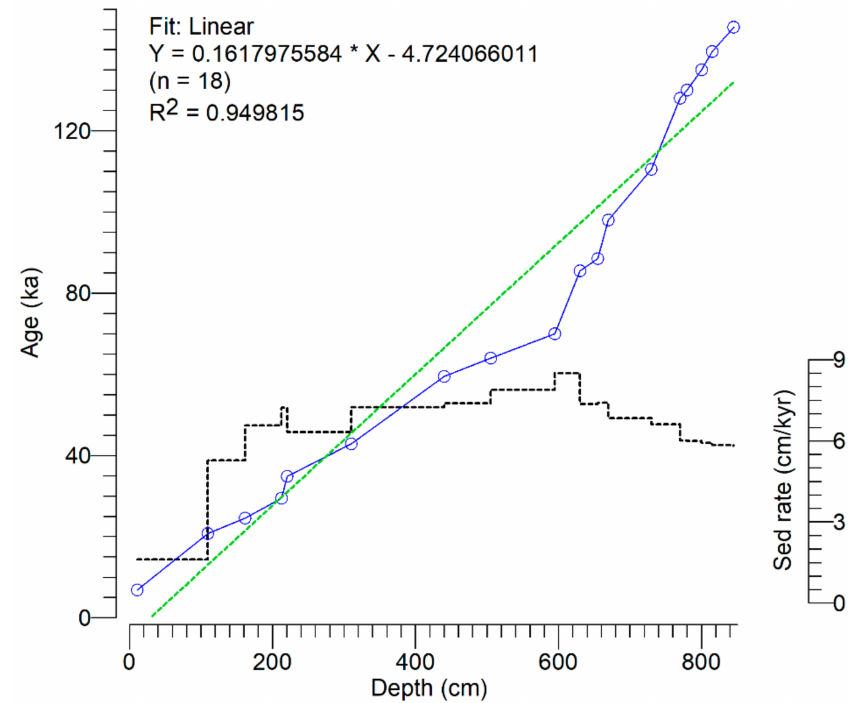
Figure 4. Age model of core Hu90-08 (this study) using the C14-AMS dates and tie points listed in Table 2. A linear fit (discontinuous green line) with the R 2 = 0.949815 suggests a robust depth-age relationship, and the core contains climate records between 3.54 and 145 ka from 0 to 841.5 cm. Sedimentation rates range from 1.62 cm/kyr to 8.5 cm/kyr in which the Holocene period shows the lowest sedimentation